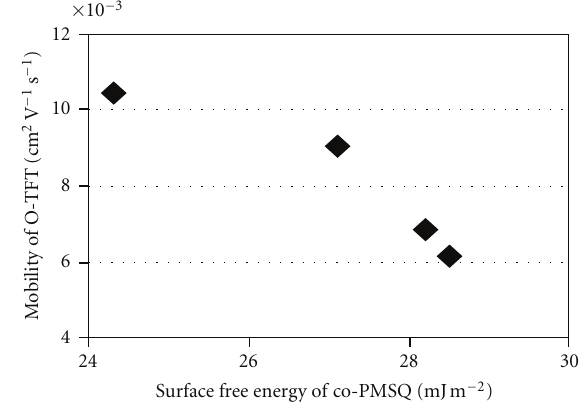
Figure 12: Relationships between mobility of O-TFTs and surface free energy of co-PMSQ gate-insulating